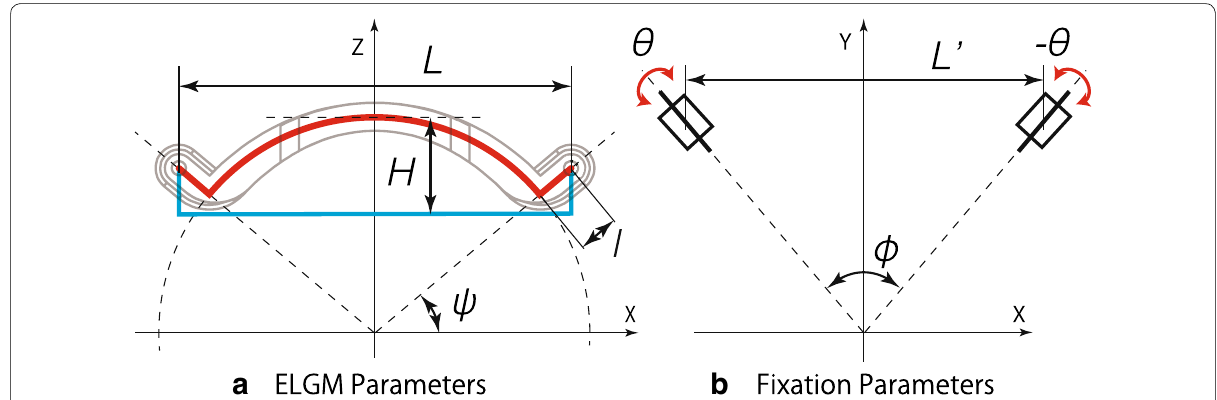
Fig. 4 ELGM design rules. a ELGM design parameters. L is the length between two hinged ends, and H is the height between the red and blue lines. The red line shows the initial posture of the ELGM which corresponds to the opening phase of the eyelid, and the blue line shows the deformed posture of the ELGM, which corresponds to the eyelid closure phase of the ELGM. H refers to the width between the upper and lower eyelids, l is the length of the handle part of the ELGM, and ψ is the inclination of the handle. b ELGM fixed on an eyeglass-type frame. φ is the angle between the rotation axes on the handle parts, L ′ is the width between the fixed ends, and θ is the rotational input angle transmitted by the pulley mechanism to deform the